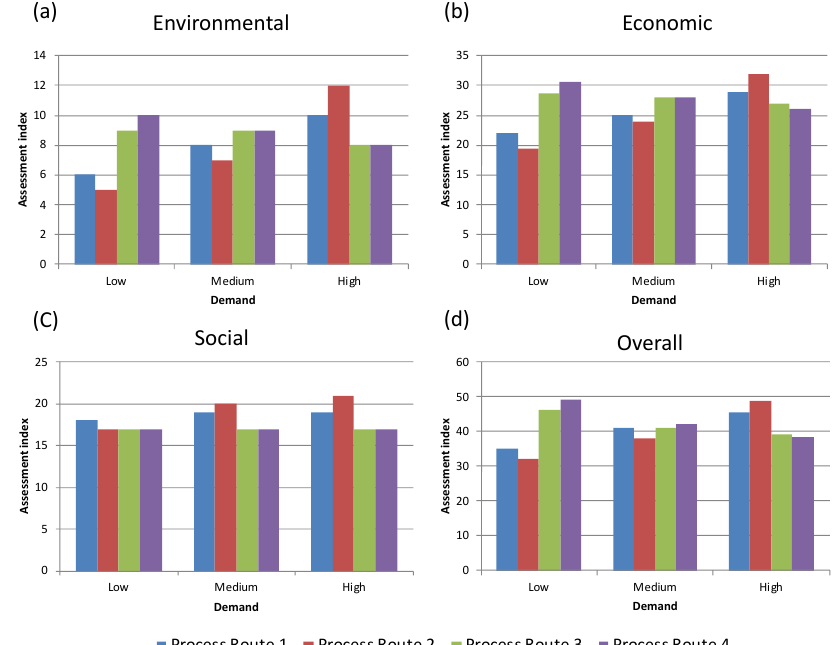
Figure 13. Ranking of process routes when the focus is on the ( a ) environmental, ( b ) economic, and ( c ) social pillar of sustainability for two different demand levels; ( d ) Presents the overall performance for equally weighted criteria.